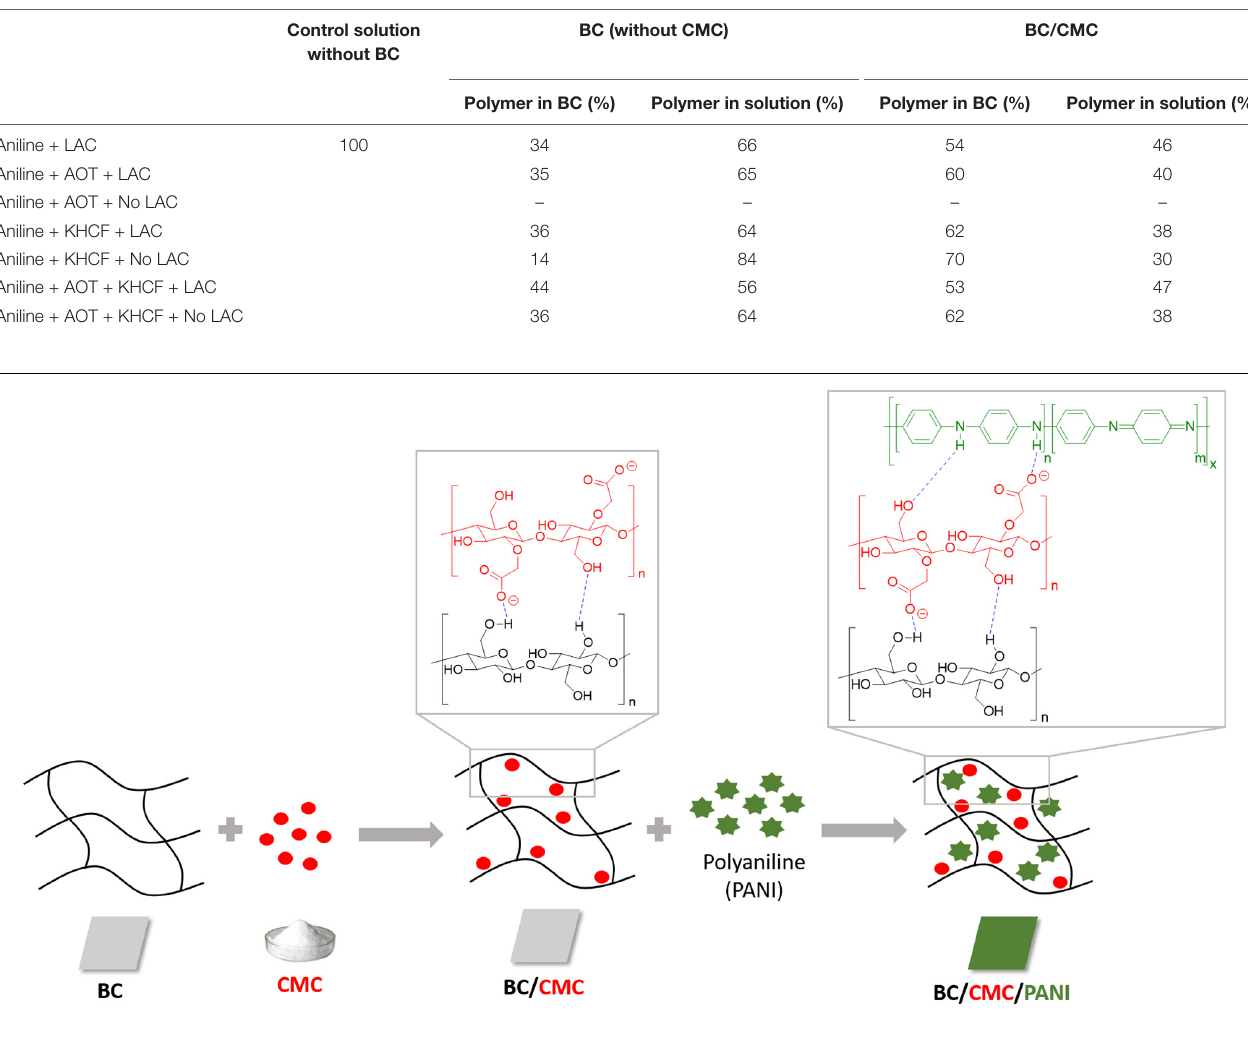
TABLE 2 | Yield of polymerization of aniline in the presence of additives inside BC and BC/CMC (calculated from weight of polymer obtained after oxidation). Control solution BC (without CMC) BC/CMC without BC Polymer in BC (%) Polymer in solution (%) Polymer in BC (%) Polymer in solution (%)